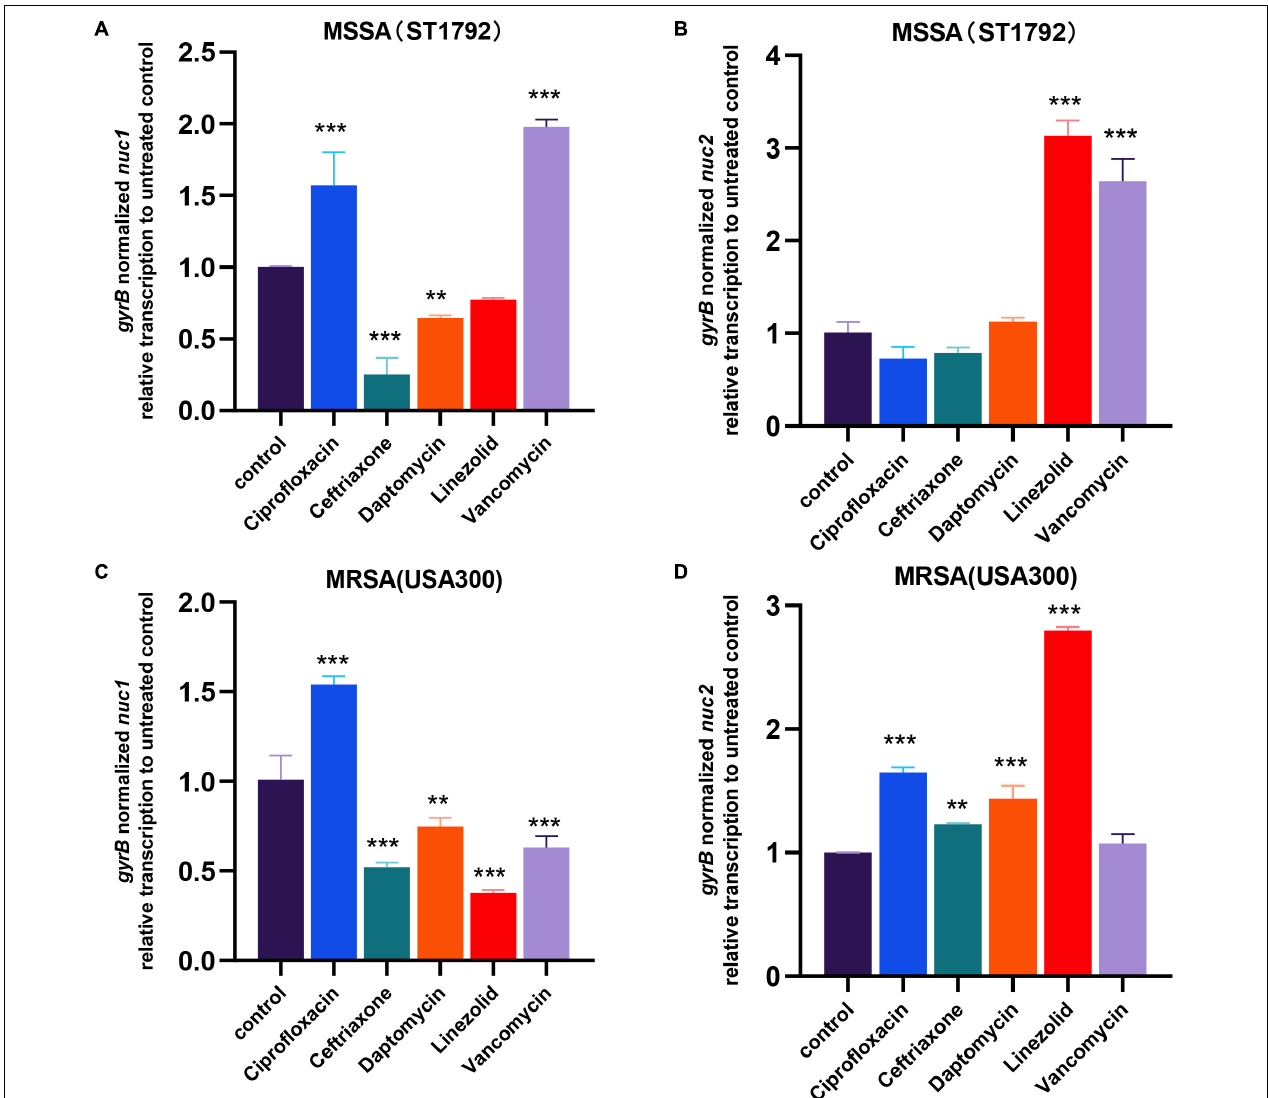
FIGURE 8 | nuc1 and nuc2 transcription changes when exposed to antibiotics in MRSA (USA300) and MSSA (ST1792). (A,B) nuc1 (A) and nuc2 (B) transcription changes in MSSA (ST1792). (C,D) nuc1 (C) and nuc2 (D) transcriptional changes in MRSA (USA300). Statistical significance was calculated using ANOVA with Dunnett multiple column comparisons. ** p < 0.01; *** p < 0.001 vs. non-treated